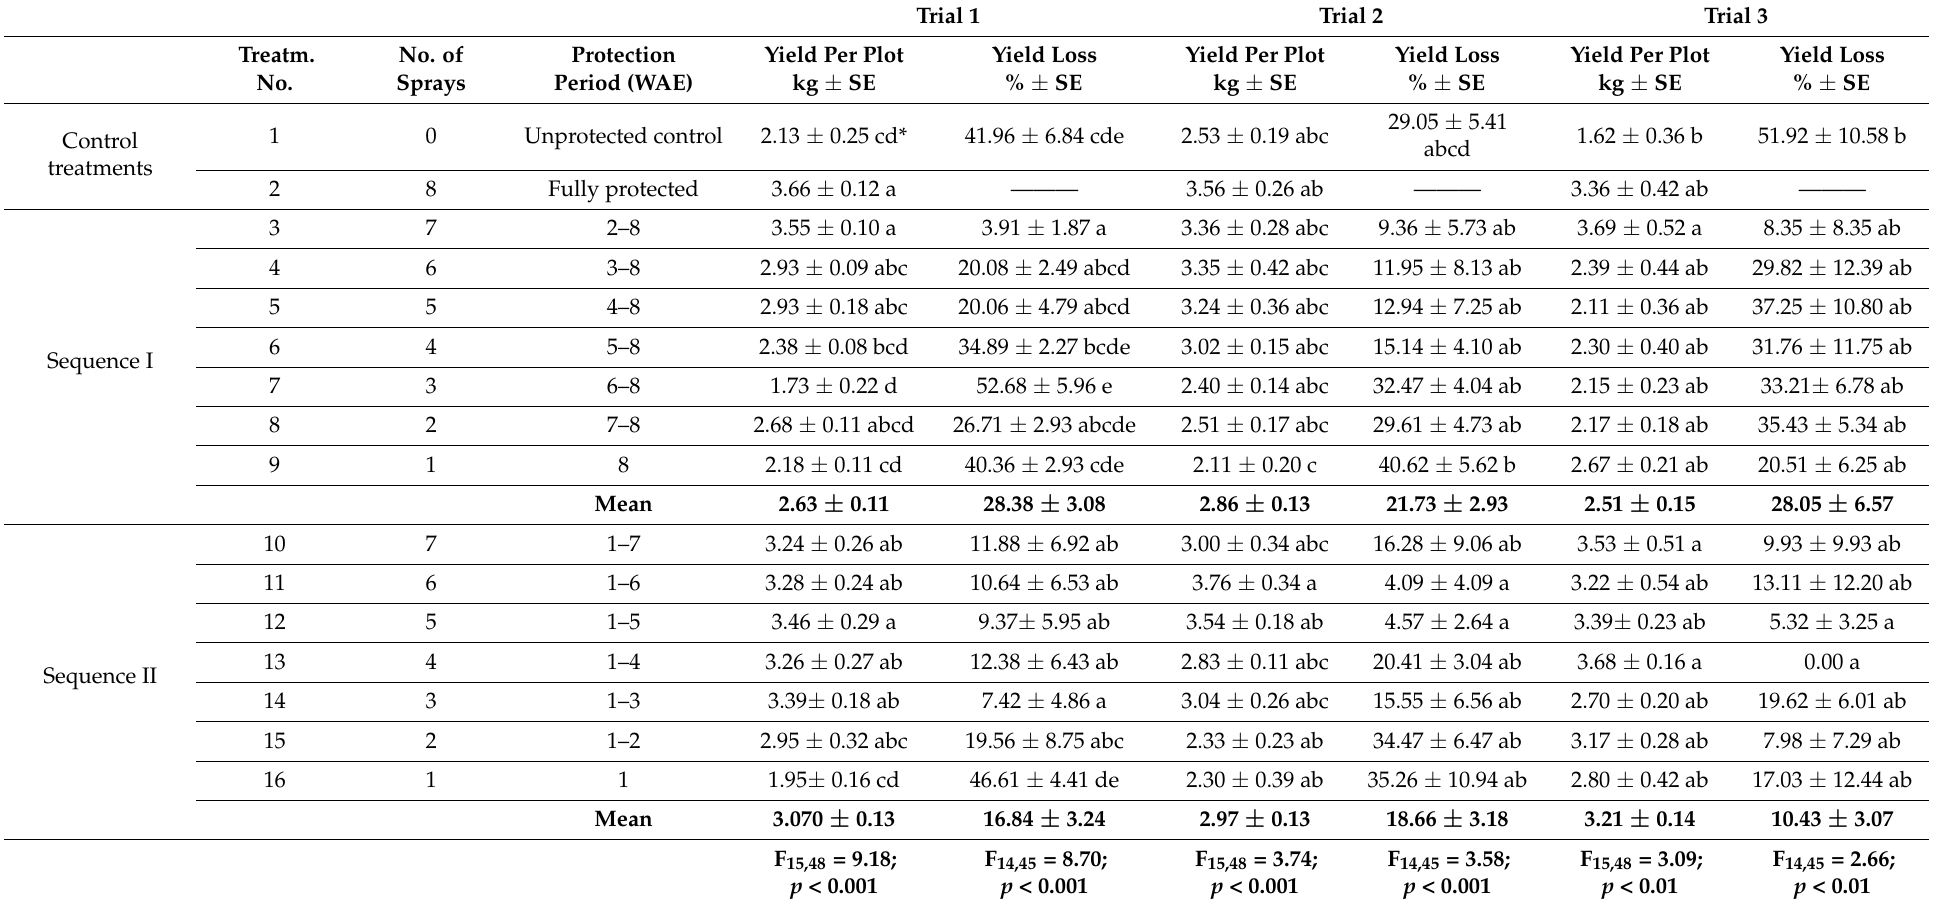
Table 3. Yield and yield loss of maize protected against FAW damage for different periods of time, from 1 week after seedling stage to 8 WAE. SE = standard